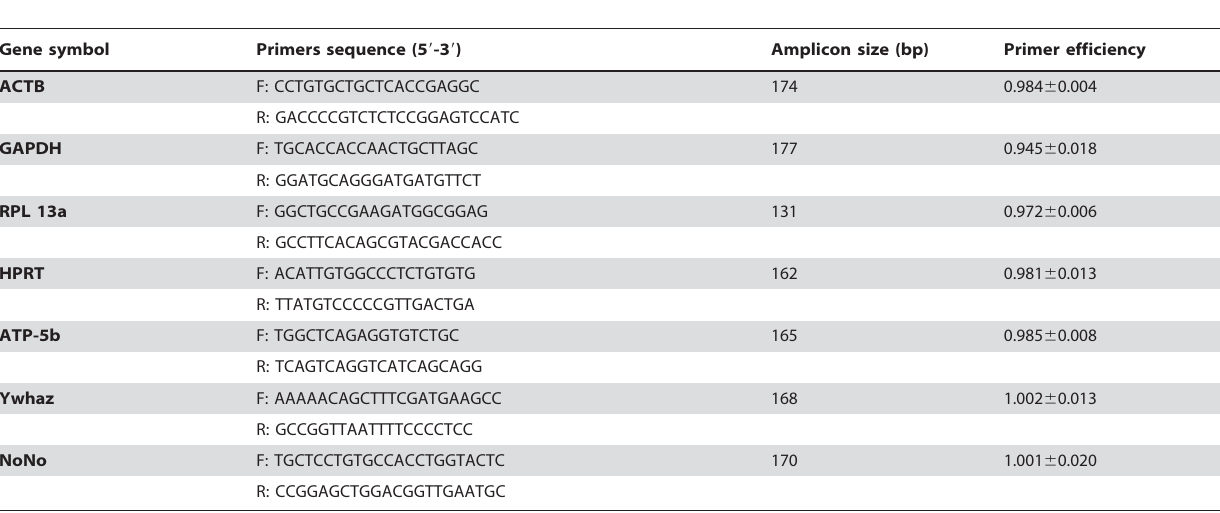
Table 2. Gene symbols, primer sequences, amplicon sizes and primer efficiencies of the candidate RGs evaluated.